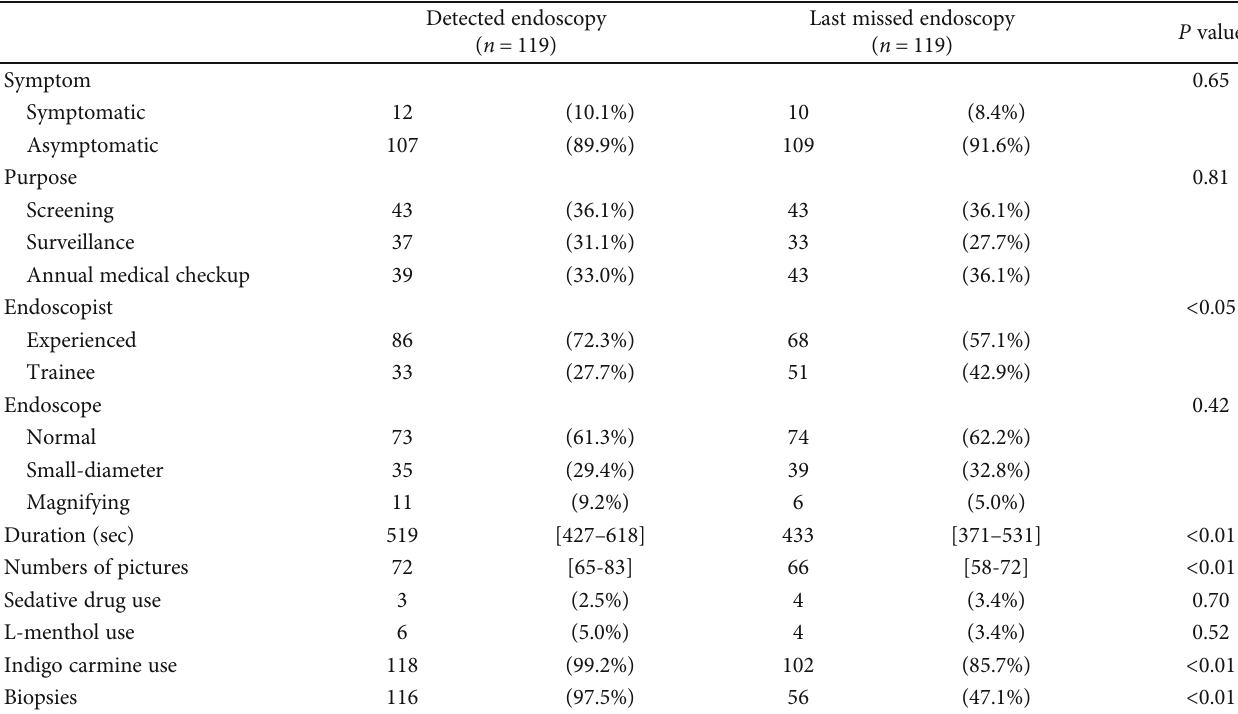
Table 2: Comparison between the detected and last missed endoscopy.